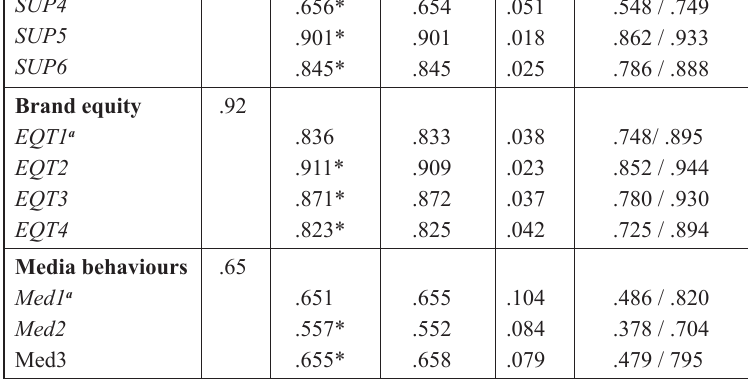
Table 2. Means, standard deviations, correla- tions, average variance extracted and compos- ite reliability scores